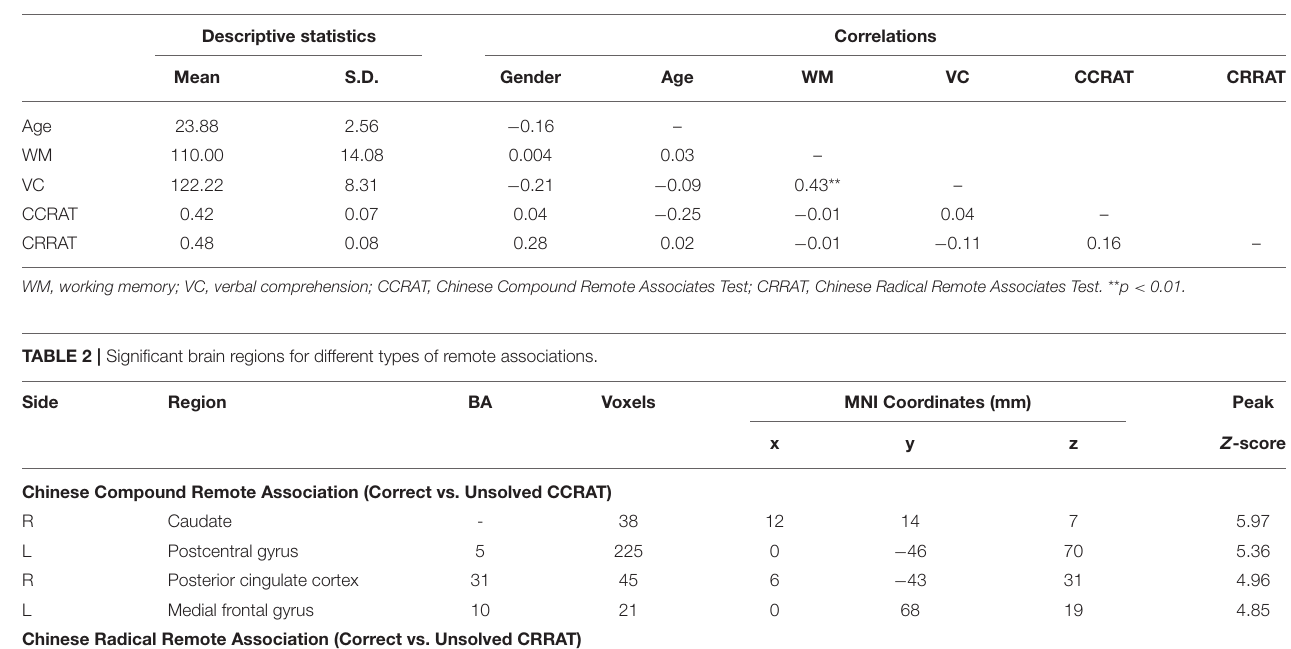
TABLE 1 | Descriptive statistics and correlation coefficients of variables.